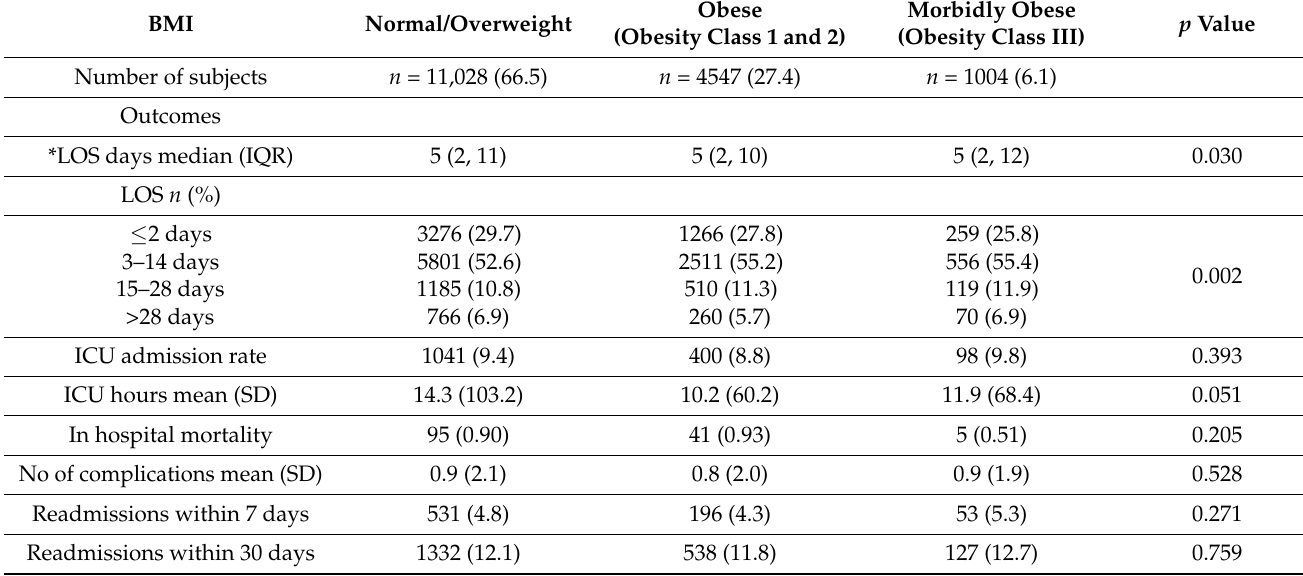
Table 3. Clinical outcomes in morbidly obese compared to non-morbidly obese.